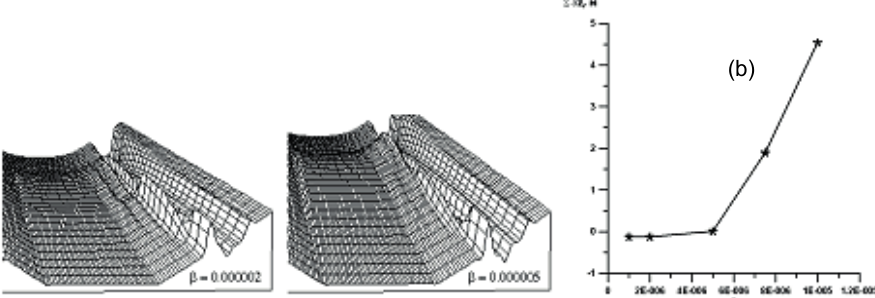
Fig. 6 The topography of the coastal slope formed after 40 minutes of the simulated time after the start of the experiment at different soil cohesion coefficients ( Krel = 1.5) (a), the dependence of sum of deviations of the bed surface from the soil cohesion coefficient